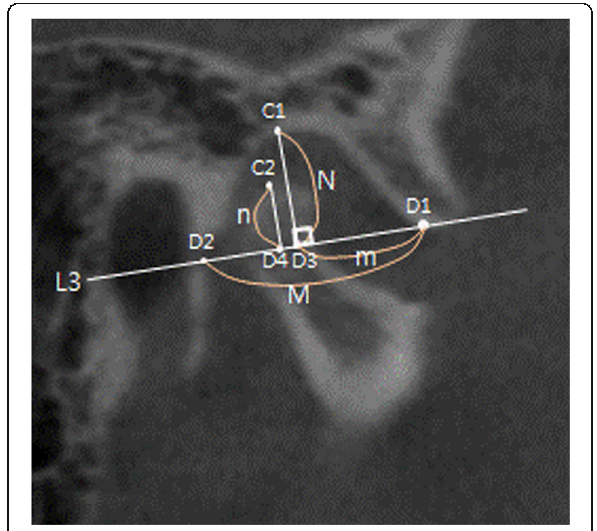
Fig. 2 Reference points and measurement of sagittal view in CBCT. C1 highest point of glenoid fossa, C2 highest point of condylar head, D1 lowest point of articular eminence, D2 lowest point of temporal squamotympanic fissure, L3 line passing D1 and D2, D3 point meeting the perpendicular line from C1 on L3, D4 point meeting the perpendicular line from C2 to L3, M distance between D1 and D2, m distance between D1 and D3, N distance between C1 and D3, n distance between C2 and D4, S – N n / N (assessed by ratio of vertical location of mandibular condyle at glenoid fossa), S – M, m / M (assessed by ratio of horizontal location of mandibular condyle at glenoid